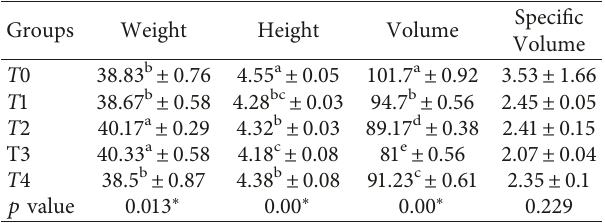
Table 2: Physical properties of various gluten-free cupcakes and control. Groups